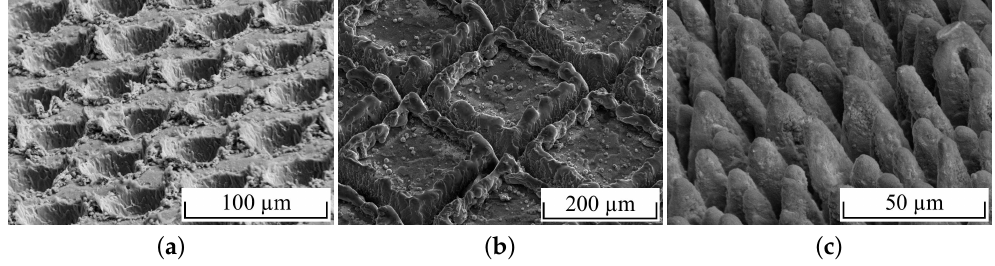
Figure 2. Topography images of laser structured surfaces with different processing strategies: ( a ) crater, ( b ) groove [4], ( c ) CLP